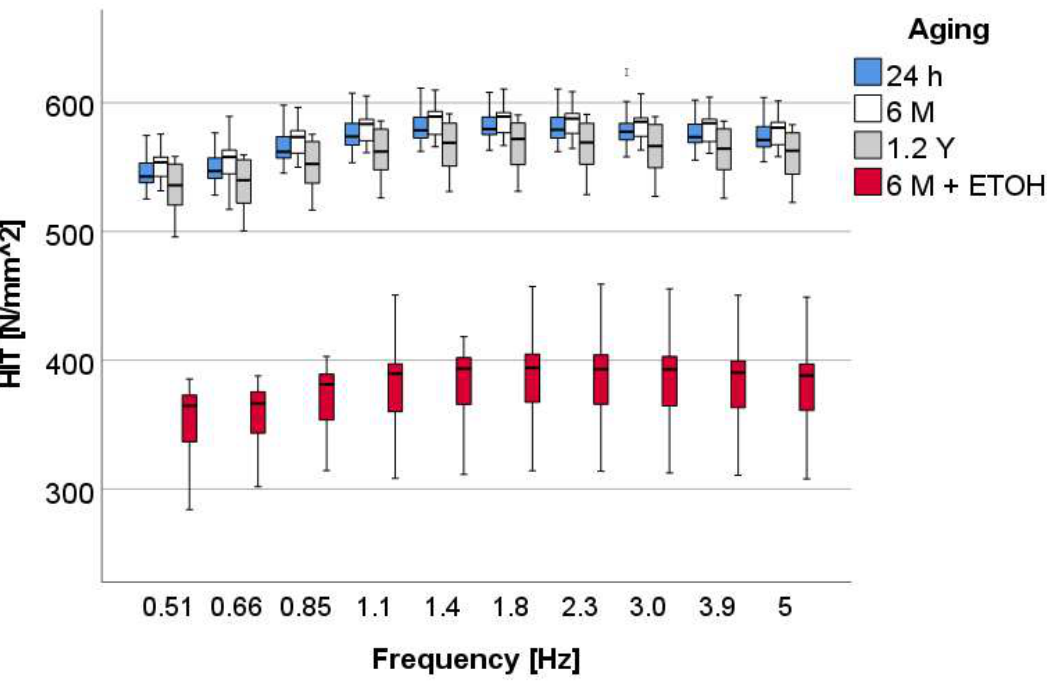
Figure 5. Indentation hardness (H IT ) as a function of frequency and aging method, exemplified for the material OC.